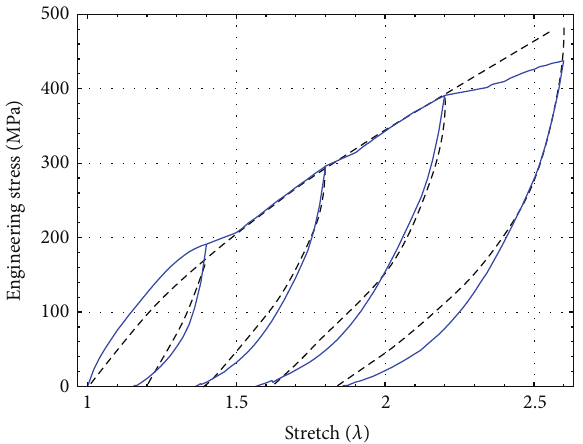
Figure 9: Engineering stress-stretch data for polypropylene sutures compared with theoretical predictions of the nonmonotonous amended average-stretch, full-network model for which 𝜇 = 200 MPa, 𝑁 = 30.5 , 𝑏 = 0.65 , and 𝐶 = 0.00265 MPa. The dashed black lines represent theoretical predictions, and the blue solid lines describe experimental